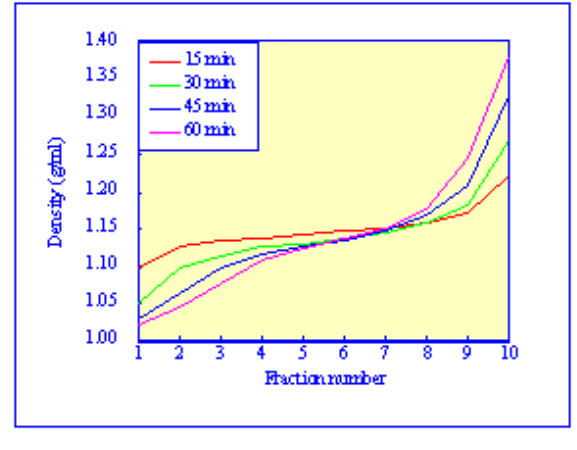
FIGURE 6 . Density profiles: Sorvall S150-AT fixed-angle rotor from 25% iodixanol at 710,000 g at 16 o